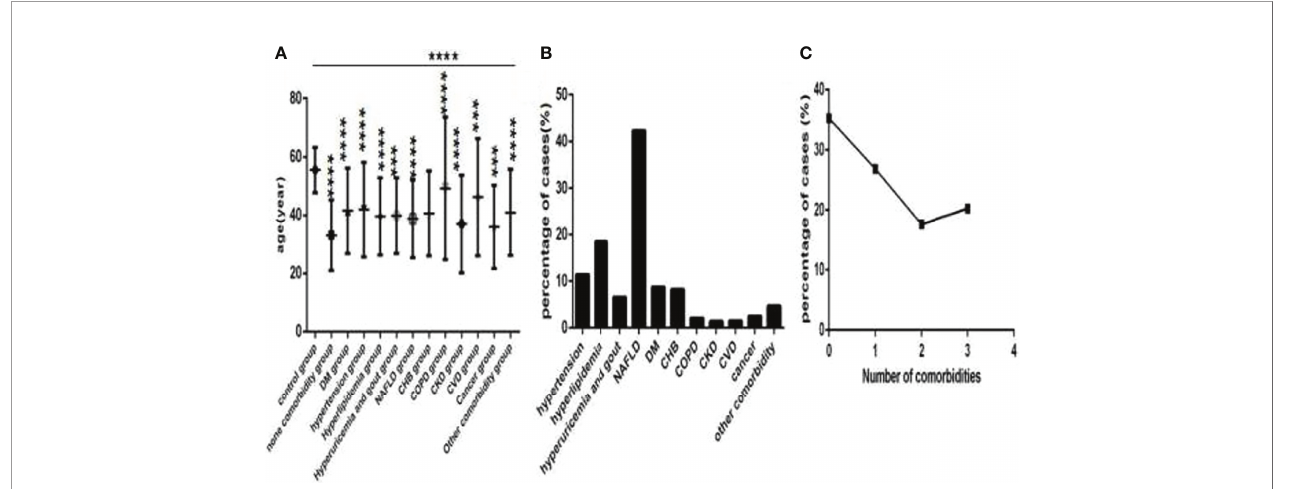
FIGURE 2 | Comparison of age among the control group, the no comorbidity group and each comorbidity group, and the distribution characteristics of the number and type of comorbidities in COVID-19 patients ( n =773). COVID-19, coronavirus disease 2019. NAFLD, nonalcoholic fatty liver disease. DM, diabetes mellitus. CHB, chronic hepatitis (B) COPD, chronic obstructive pulmonary disease. CKD, chronic kidney disease. CVD, cardiovascular disease. (A) age. (B) the percentage of each type of comorbidity. (C) The percentage of different numbers of comorbidities. One-way ANOVA was used for intergroup comparisons (P < 0.0001). Unpaired t-tests were used for comparisons with the control group, ***P < 0.001, ****P < 0.0001.